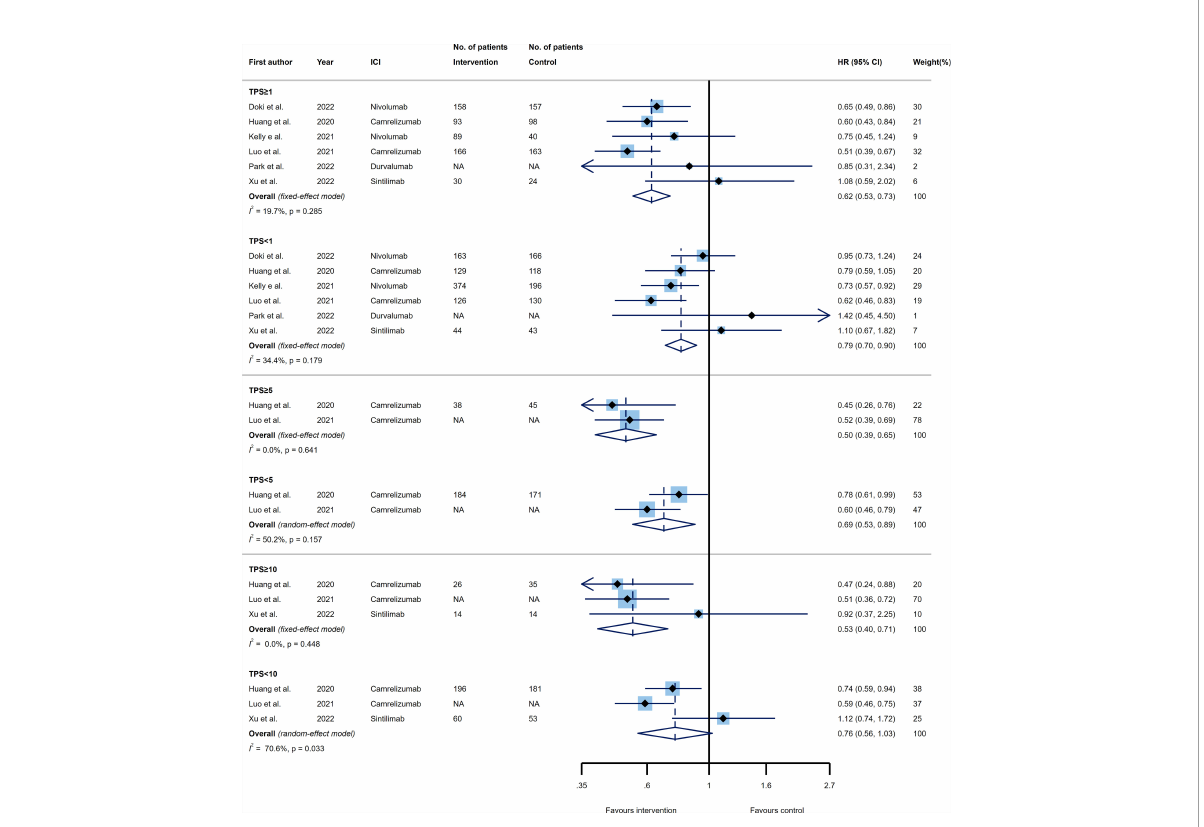
FIGURE 5 Forest plots of progression-free survival (PFS) in PD-L1 high expression group vs . PD-L1 low expression group for the thresholds of tumor proportion score (TPS)=1% (upper panel), TPS=5% (middle panel), and TPS=10% (lower panel). The squares indicate weight of each study based on the fi xed or random ‐ effect model. The vertical dashed line indicates the overall pooled estimate and the diamond the 95% con fi dence interval around that pooled estimate. The forest plot was generated using STATA 17.0 (STATA Corp, LLC,